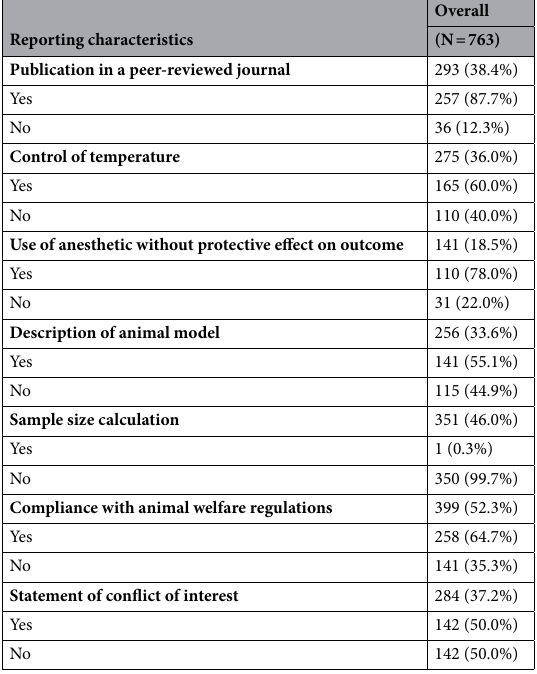
Table 6. Quality of reporting and experimental procedures of included studies in meta-analyses.